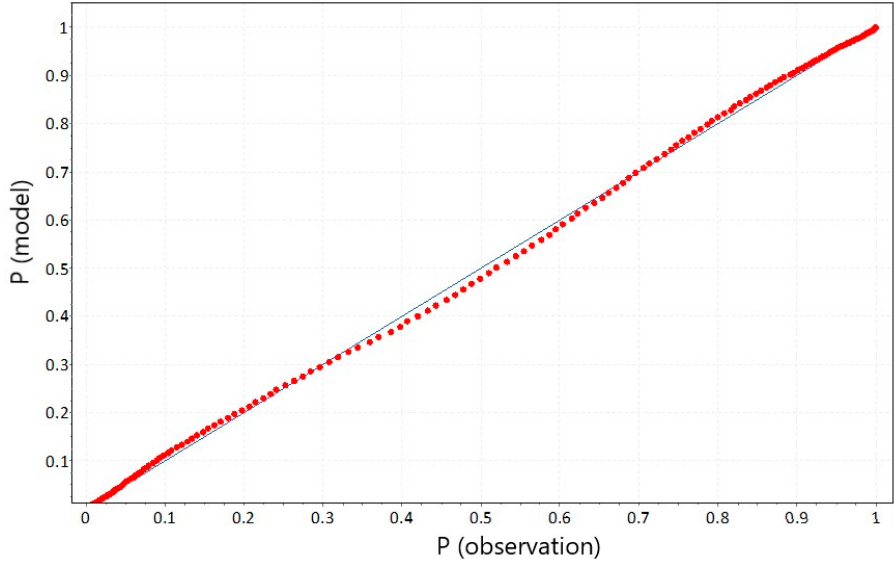
Figure 4. Histogram of the nondimensional streamflow data fitted to the normal probability distribution.